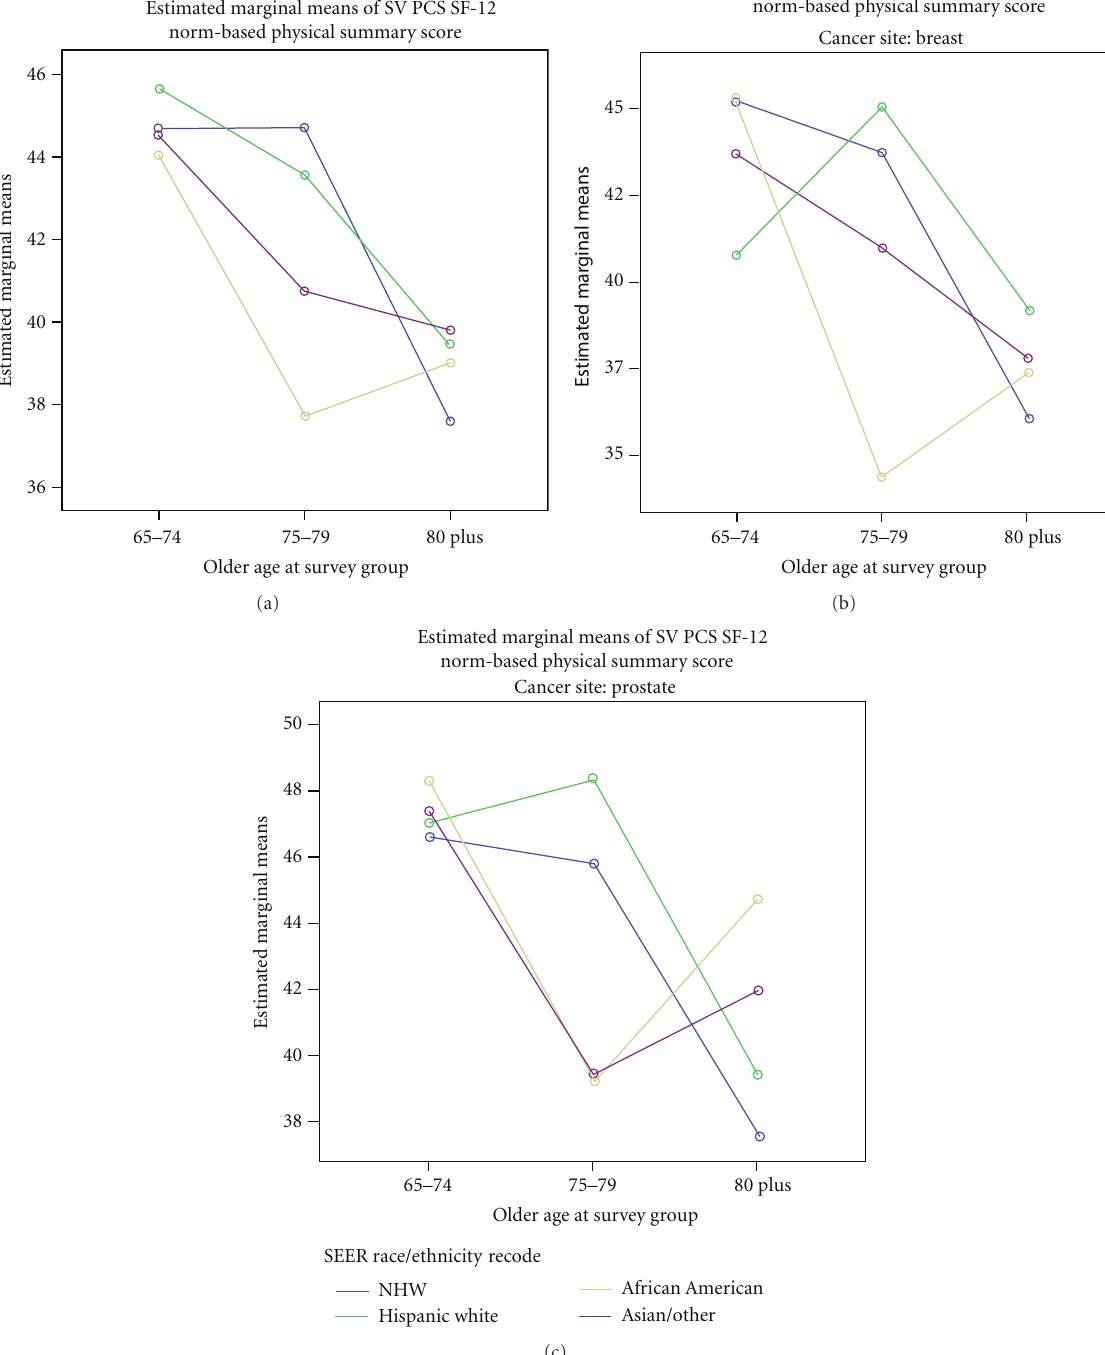
Figure 1: Age by race/ethnicity interaction plots